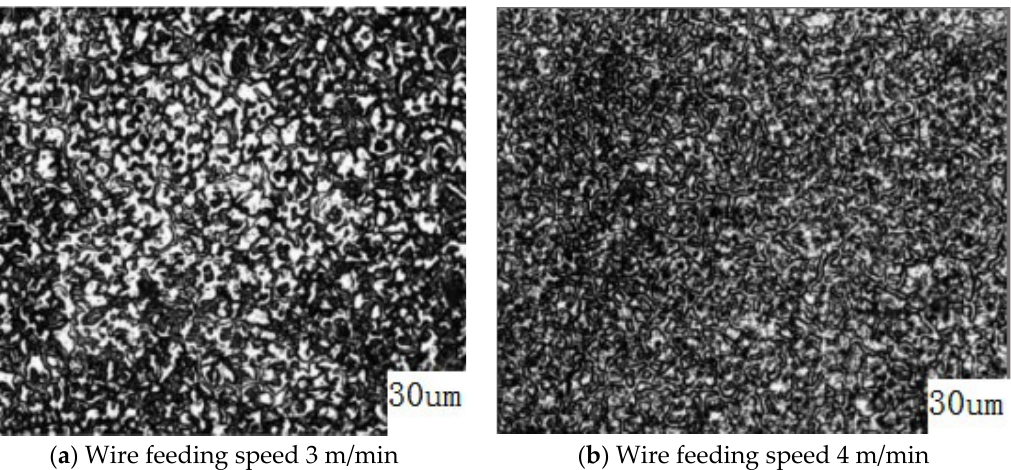
Figure 8. Metallographic organization chart at different wire feeding speeds.